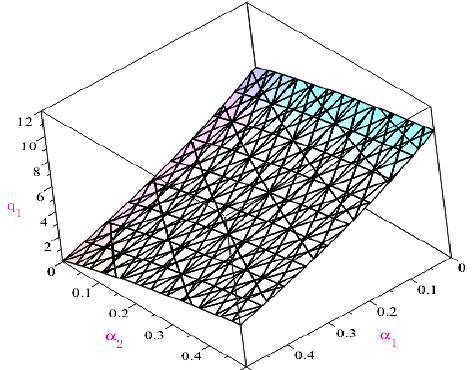
Figure 1. Changes of q